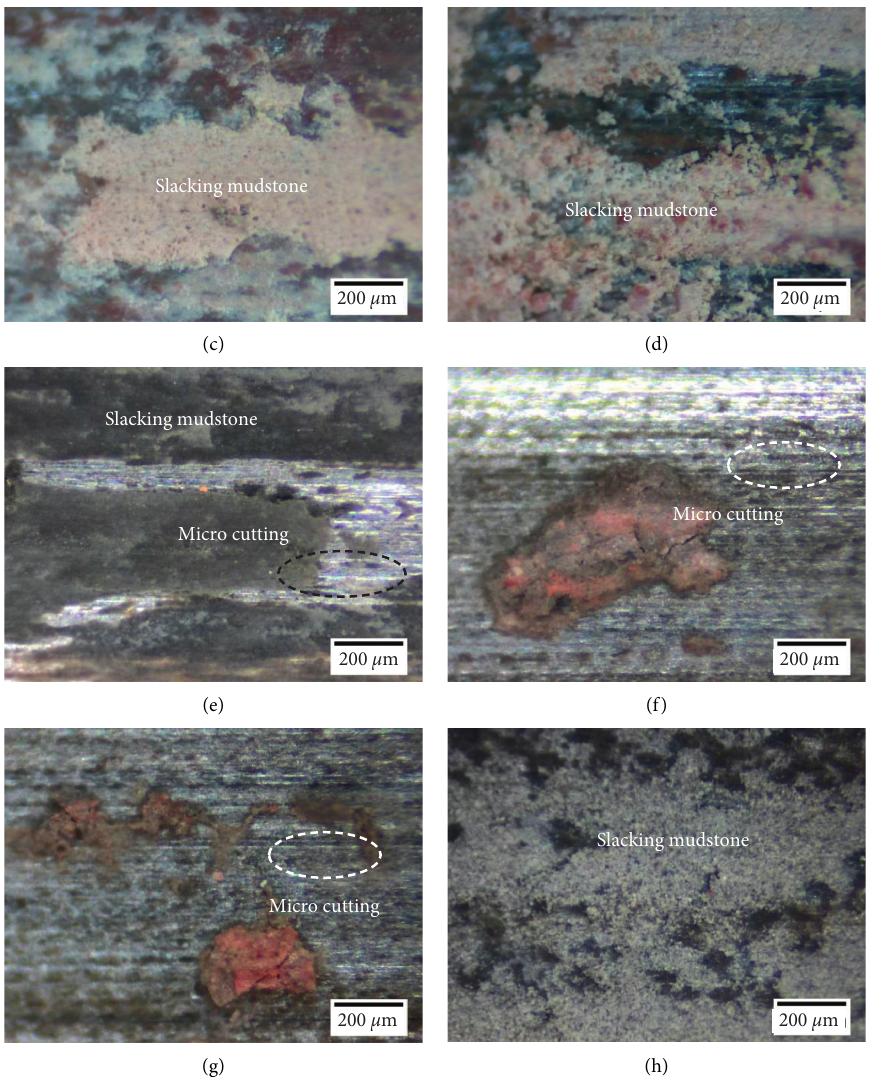
Figure 7: Evolution of disc cutter wear at × 400 magnification. (a) 5min, P / D � 0.04; (b) 10min, P / D � 0.06; (c) 15min, P / D � 0.07; (d) 20min, P / D � 0.09; (e) 30min, P / D � 0.13; (f) 40min, P / D � 0.15; (g) 50min, P / D � 0.17; (h) 60min, P / D �